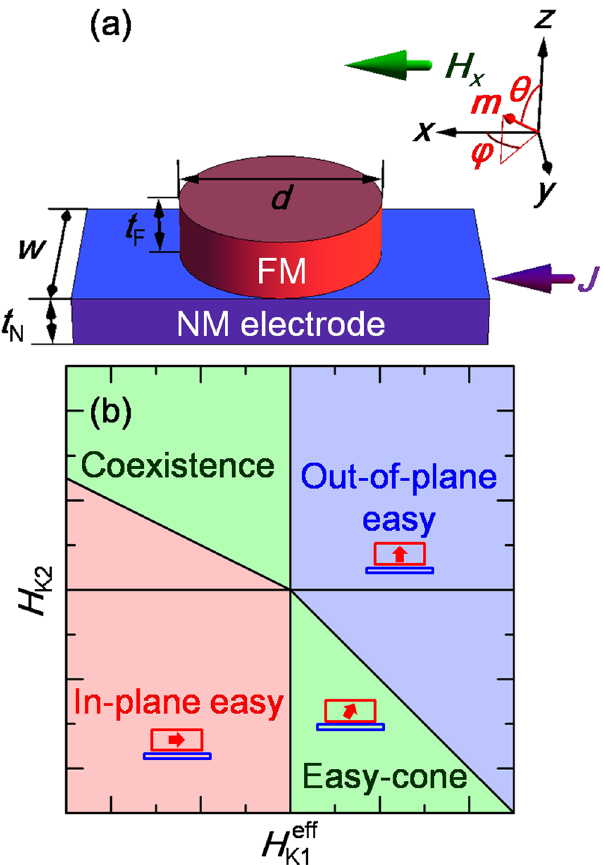
Figure 1. ( a ) Schematic showing NM/FM bilayered structure together with definition of x -, y -, and z -axes and magnetization angles of θ and ϕ . The directions of H x and J are also indicated. ( b ) Phase diagram showing stable magnetic states as functions of H K1eff and H K2